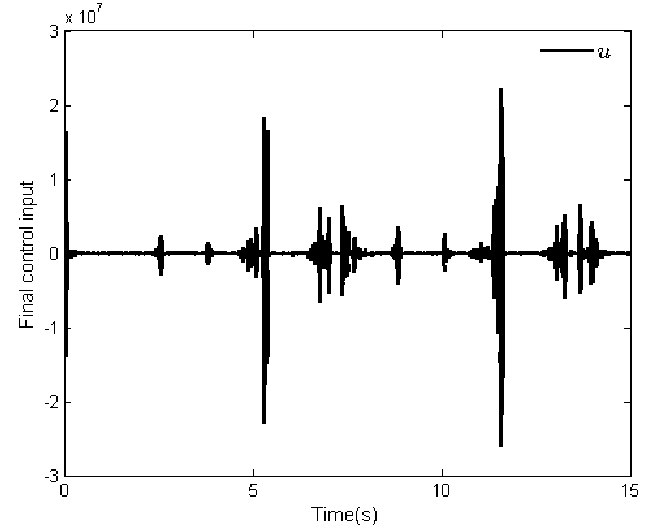
Figure 7. The curve of control input u ( t ) .